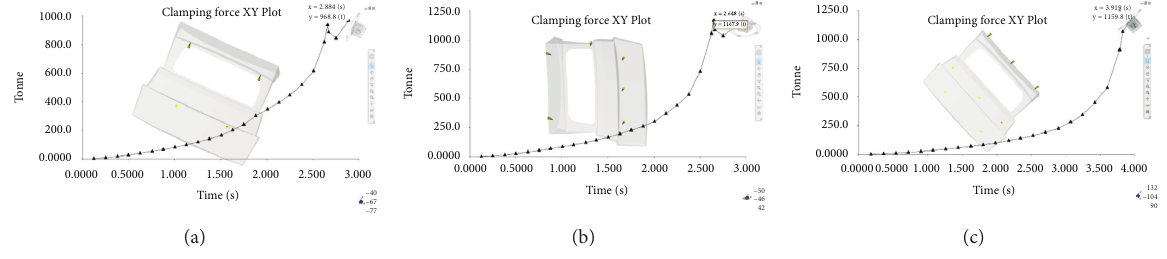
Figure 4: Clamping force with (a) four gates, (b) six gates, and (c) eight